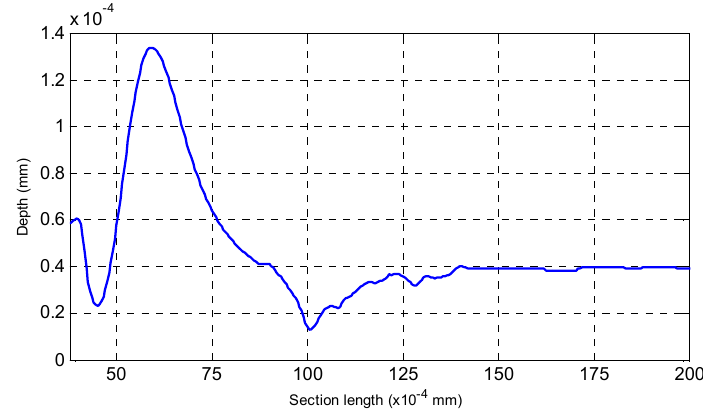
Figure 13. An arbitrary section of the reconstructed AFM cantilever.